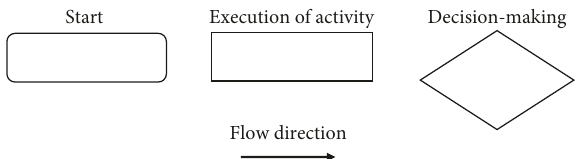
Figure 1: Commonly, a basic flowchart model (algorithm) is constituted with the following elements that compose the ad- ministrative workflow analysis for operational steps and data control [5,